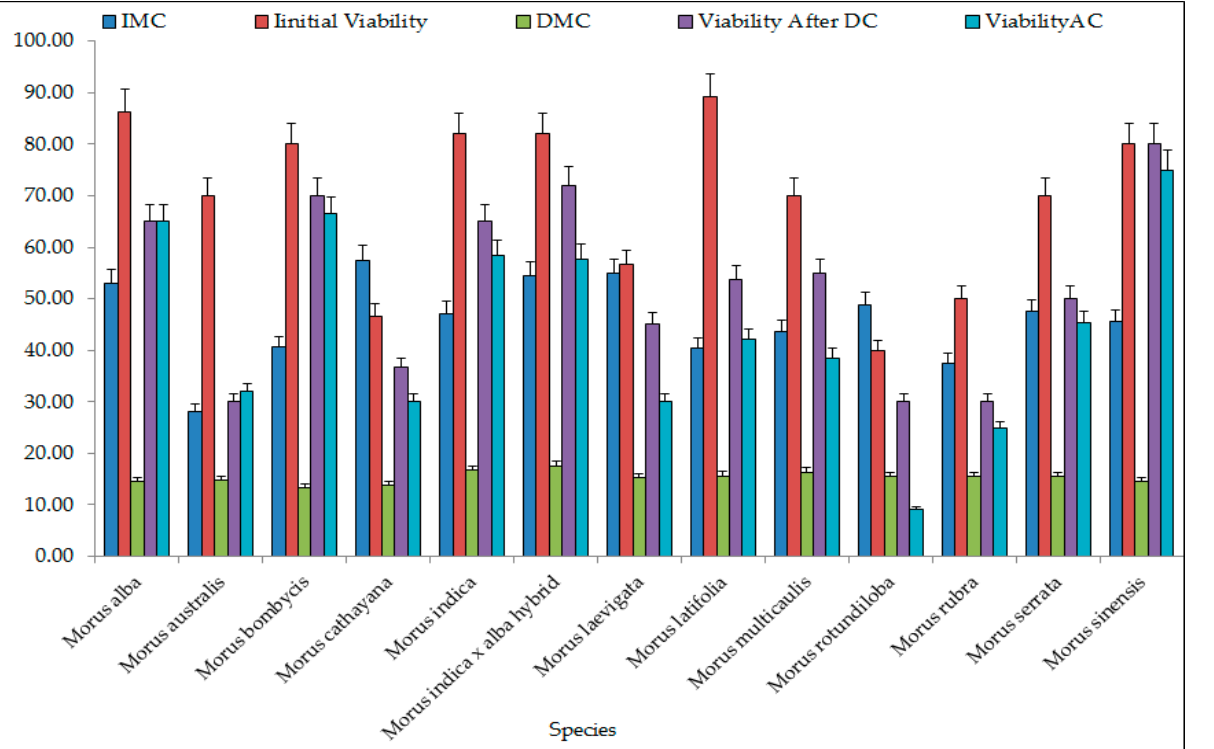
replicates (n = 3), and the means with the same letter (superscript) in the columns are not signifi- cantly different ( p < 0.05)—(Duncan’s multiple range test).